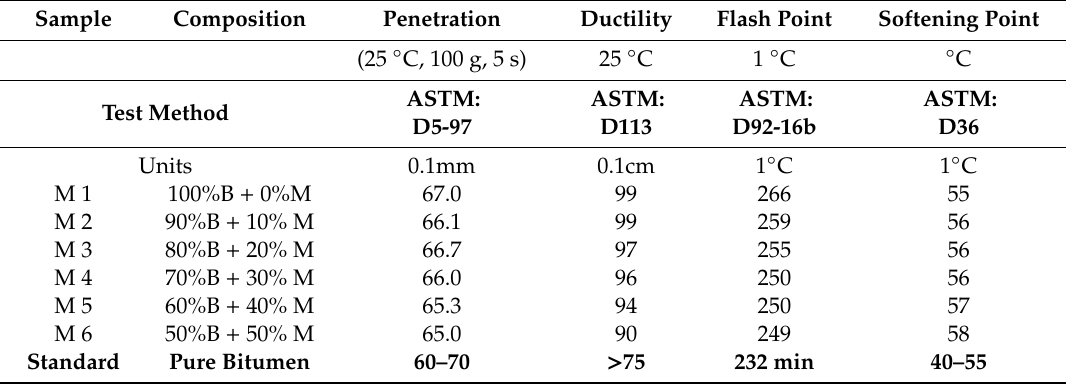
Table 3. Physical properties of